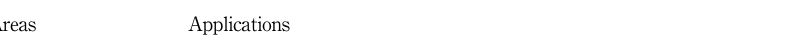
Table I. Comparison of land and Ocean management